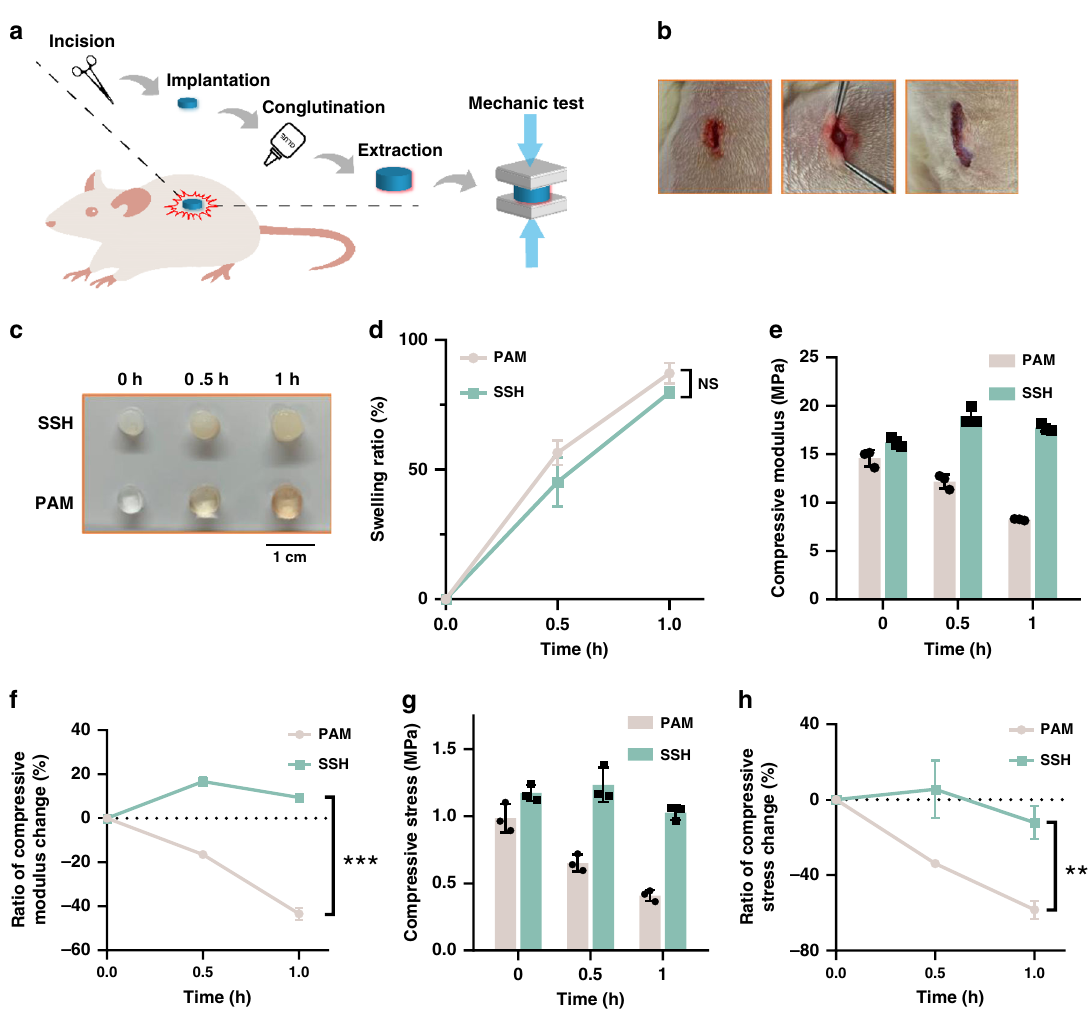
Fig. 3 Swelling-strengthening behavior of swelling-strengthening hydrogels (SSHs) in vivo. a Schematic diagram of the experimental procedure. b Photographs of the surgical implantation of SSHs in rats. Left: incision; middle: implantation; right: conglutination. A roughly 1-cm incision was made in the mediodorsal skin, and a lateral subcutaneous pocket was prepared. c Photographs and d swelling ratio of the hydrogel samples after implantation for the predetermined time points. e Compressive modulus at 90% strain versus swelling ratio. f Variation of compressive modulus versus swelling ratio. g Compressive stress at 90% strain versus swelling ratio. h Variation of compressive stress versus swelling ratio. The strain rate was 5 mm/min, and the dimension of the cylindrical samples was 5 × 3 mm. All error bars represent the mean ± SD ( n = 3 independent experiments). Signi fi cance was assessed using unpaired two-tailed Student ’ s t test, giving P values, * *P < 0.01, *** P < 0.001. NS no signi fi